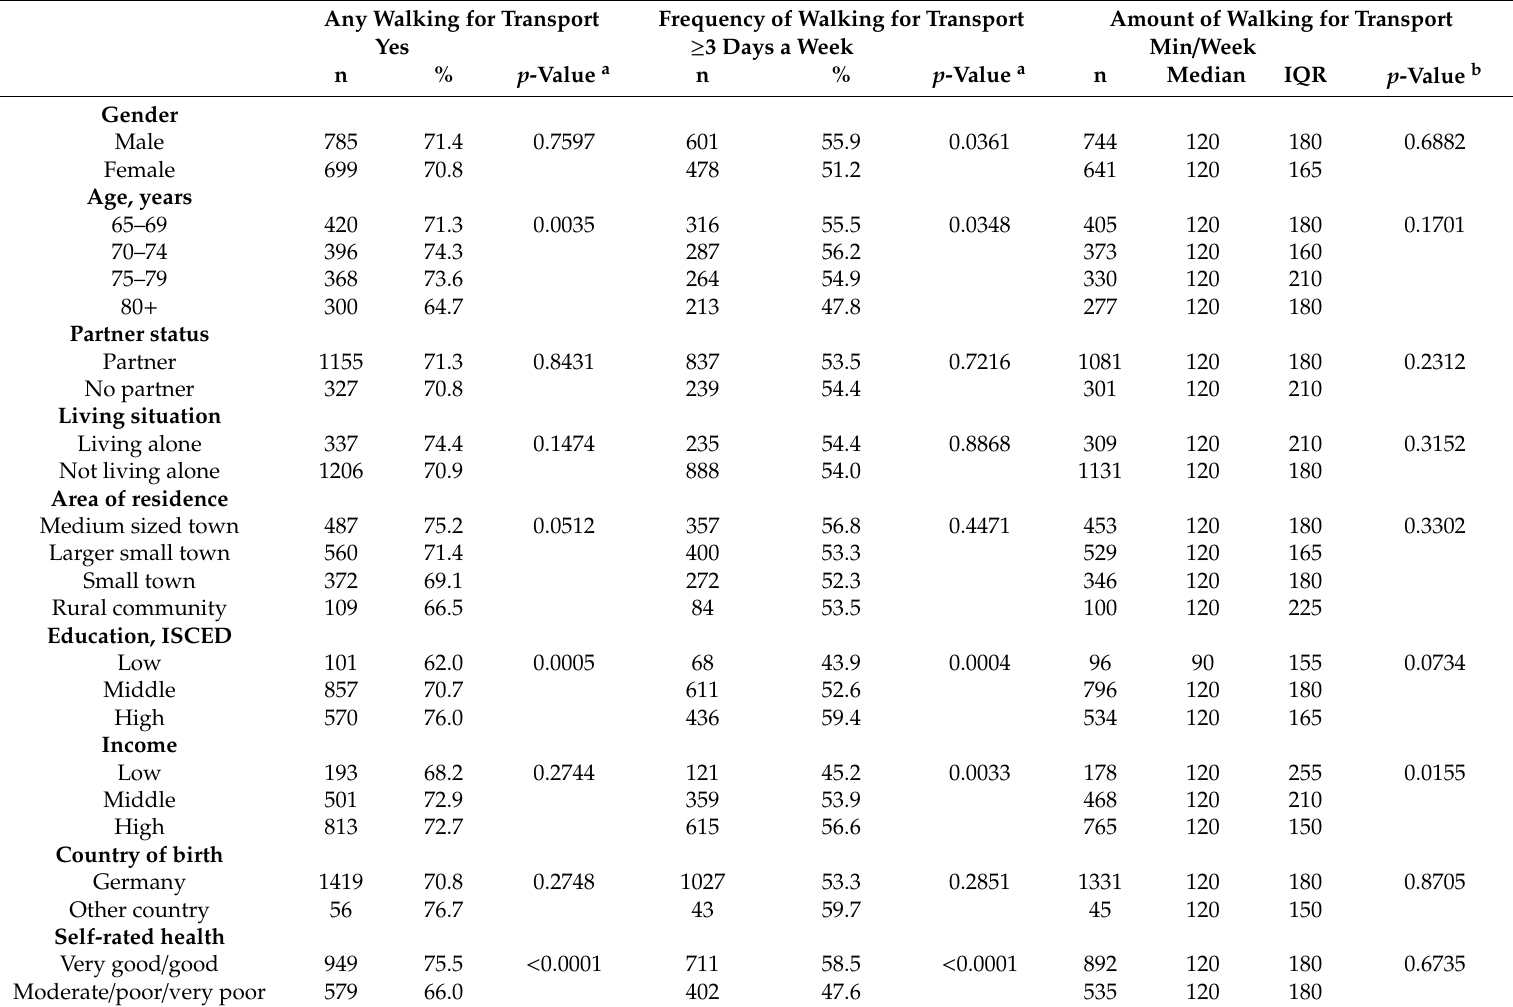
Table 2. Walking for transport by sociodemographics, health status, and transport aspects. Any Walking for Transport Frequency of Walking for Transport Amount of Walking for Transport